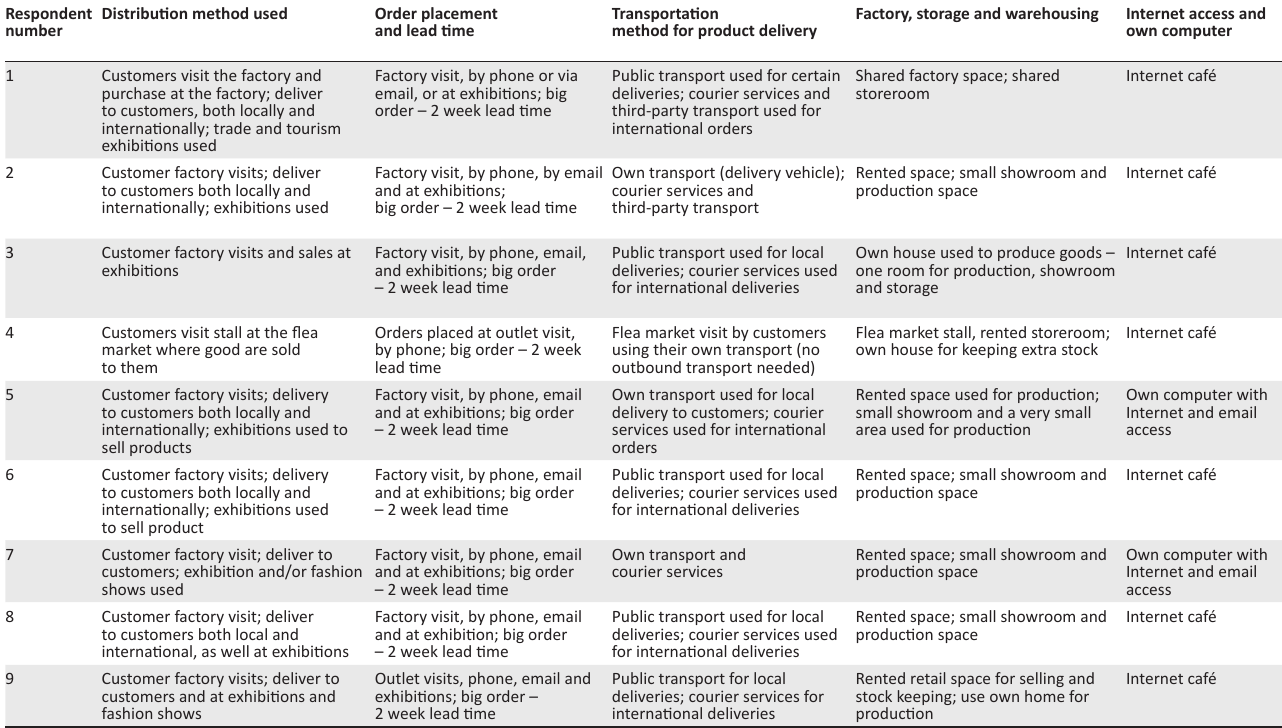
TABLE 3: Dimensions of the supply chain used by the craft business respondents. Respondent Distribution method number